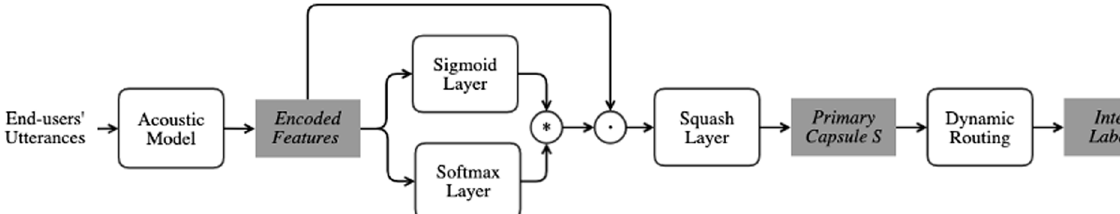
Fig. 7 The structure of the capsule network-based intent decoder